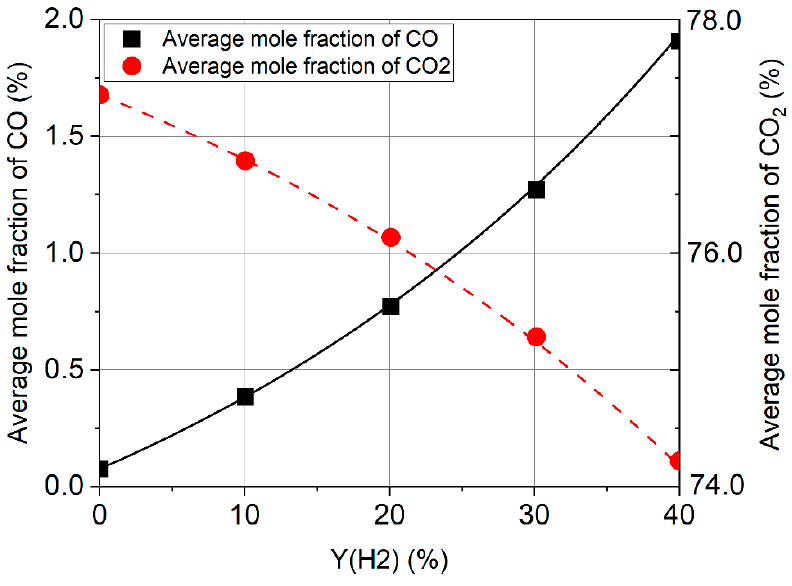
Figure 17. Dependence of CO and CO2 emissions on the molar concentration of hydrogen in a hydrogen–butane mixture [41].